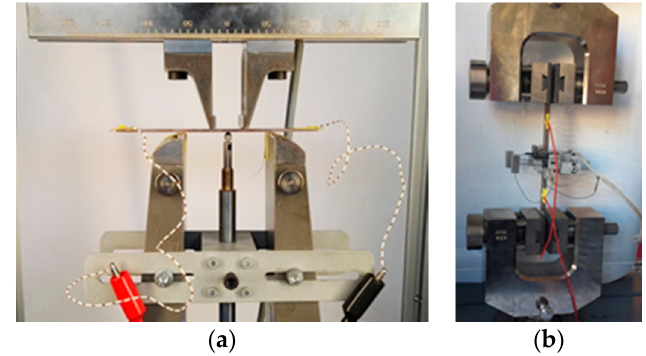
Figure 5. ( a ) Four-point bending test setup; ( b ) Tensile test setup.